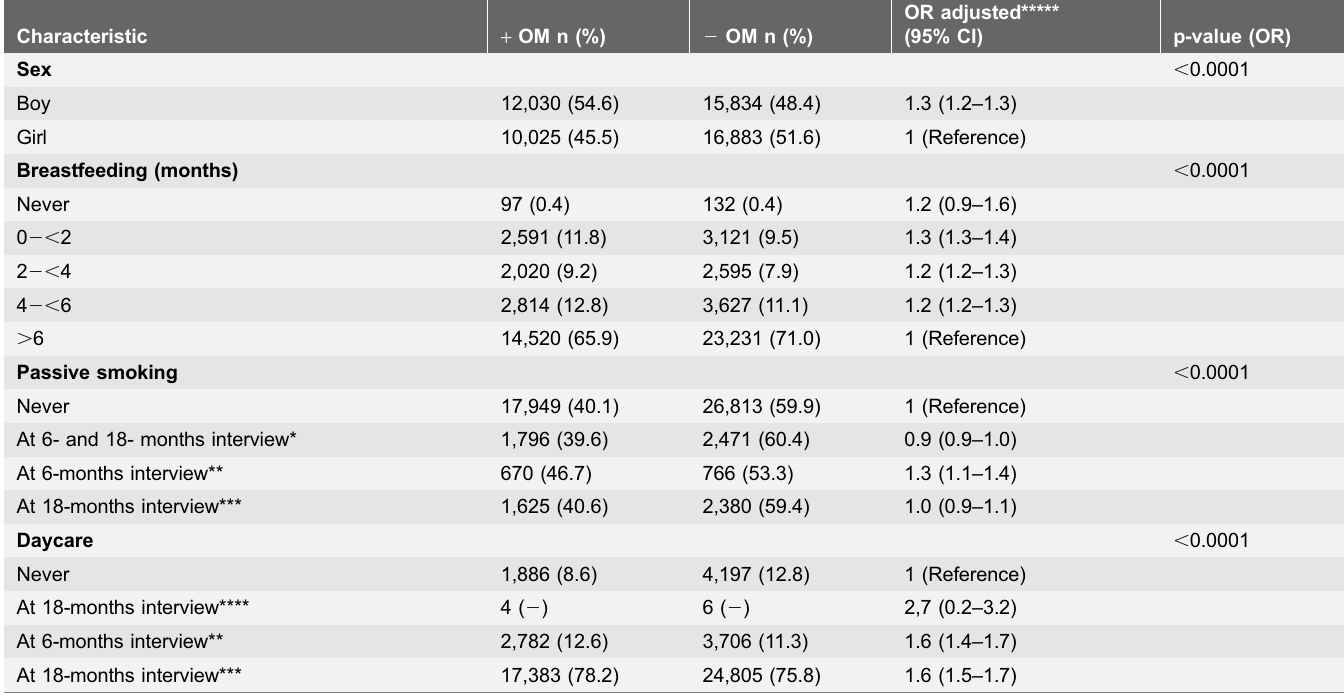
Table 1. Baseline characteristics of 54,772 children in the Danish National Birth Cohort 1996–2005, Denmark. Parents who responded both 6- and 18- months